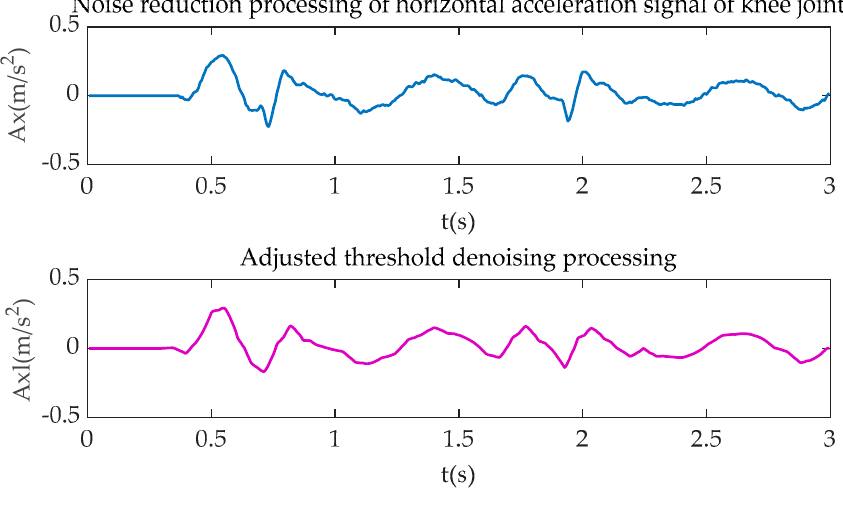
Figure 4. Knee joint horizontal acceleration processing.